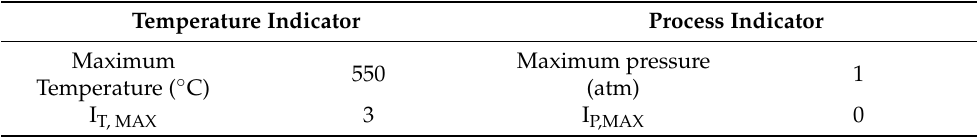
Table 5. Maximum temperature and pressure indicators.